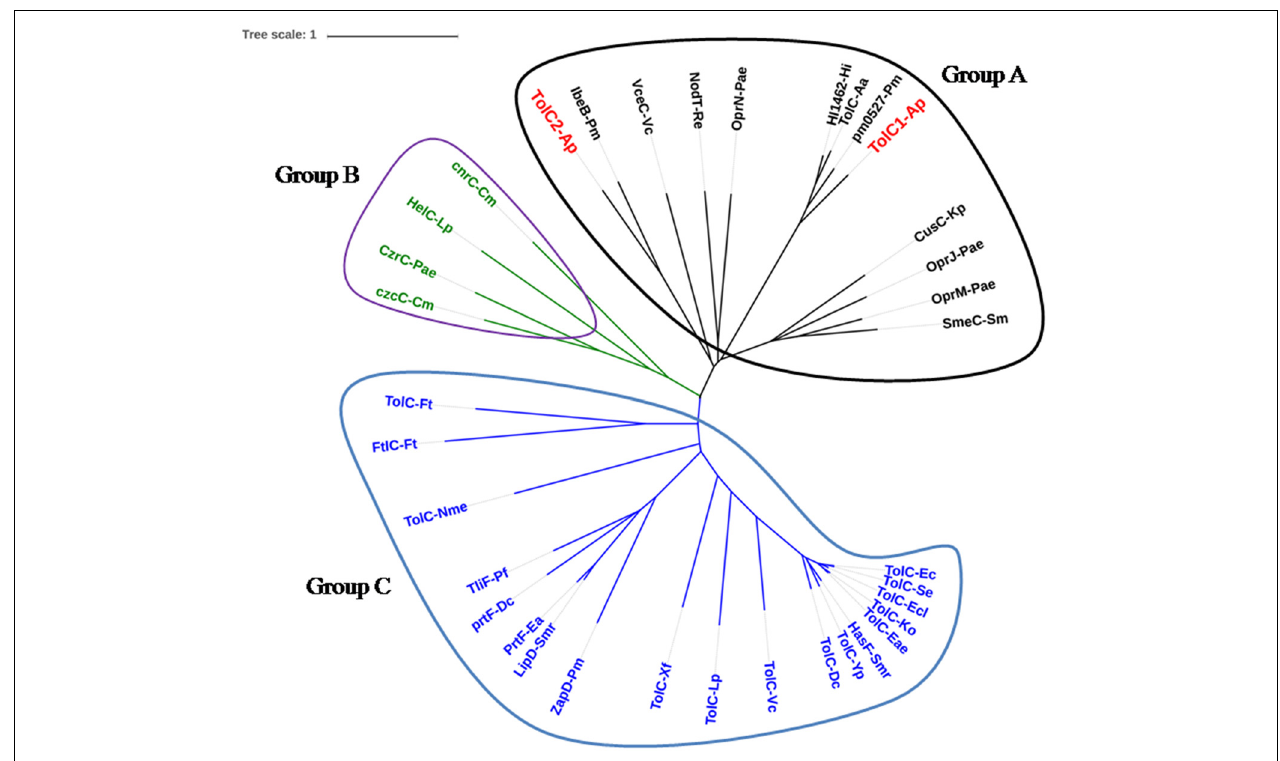
FIGURE 1 | Location of TolC1 and TolC2 of Actinobacillus pleuropneumoniae in the TolC family phylogenetic tree. The TolC homologs can be grouped into three major clades, named Groups A, B, and C. Group A proteins seem to be mainly involved in multidrug efflux (black), Group B proteins mainly in cation efflux (green) and Group C proteins are multifunctional (blue). Proteins were labeled as “protein name-species name” according to details in Supplementary Table S1.